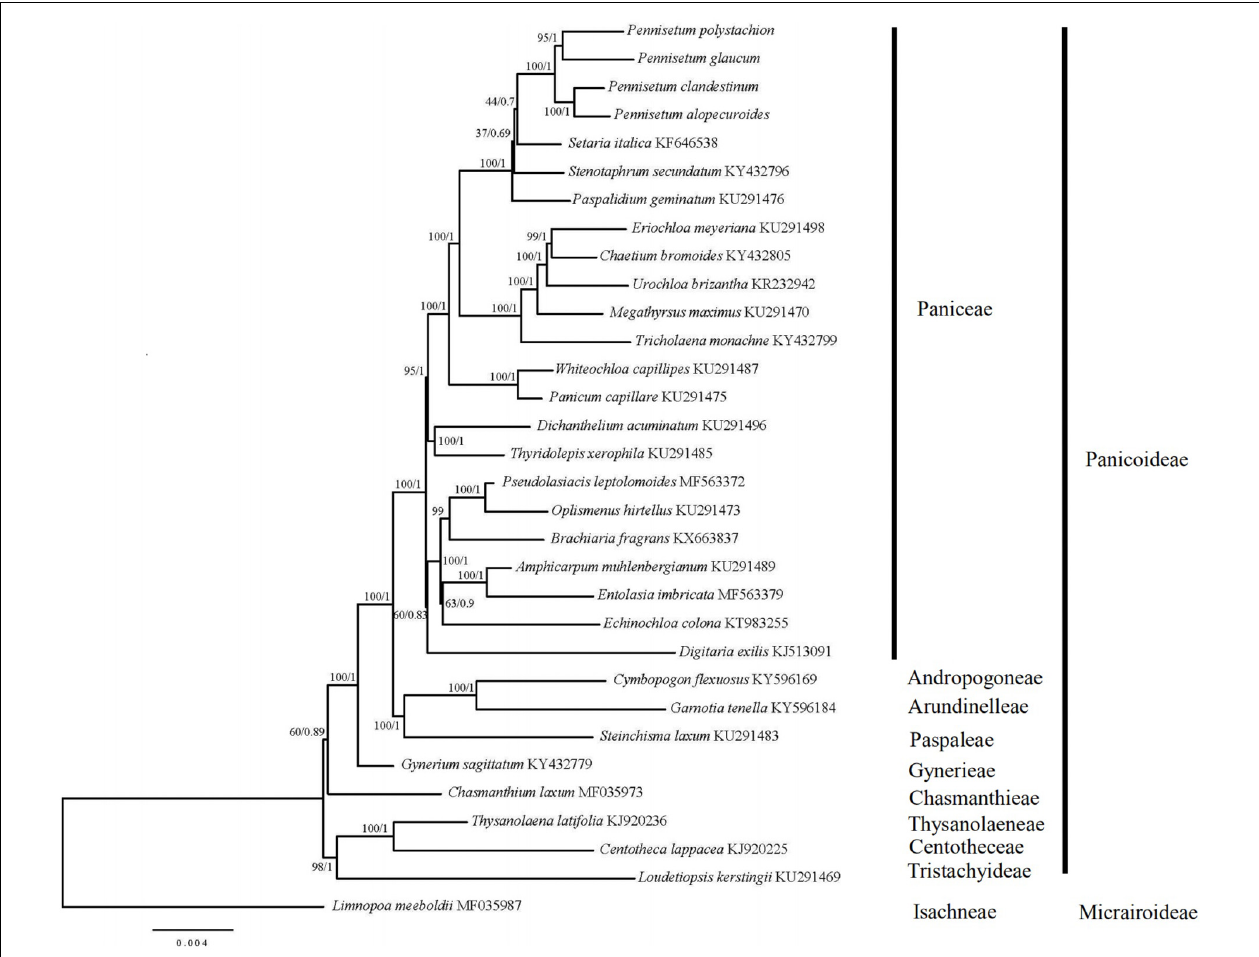
FIGURE 7 | Phylogenetic tree constructed from 32 chloroplast genomes using ML and BI method. The bootstrap values were based on 1000 replicates and were indicated next to the